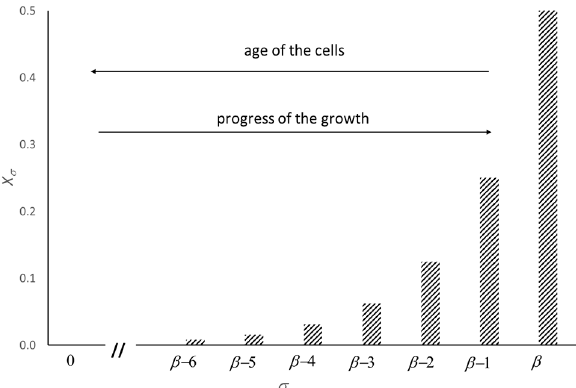
Figure 3. Population fraction, X σ , of the newborn cells at the duplication step, 0 ≤ σ ≤ β (see text). The plot allows for the ranking of the microbial population according to the age of the cells.